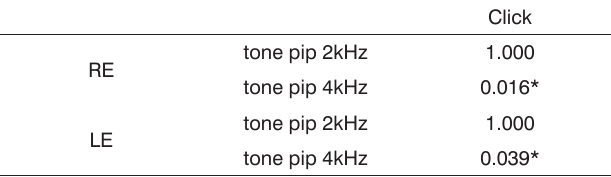
Table 3. P -values of Table 2.